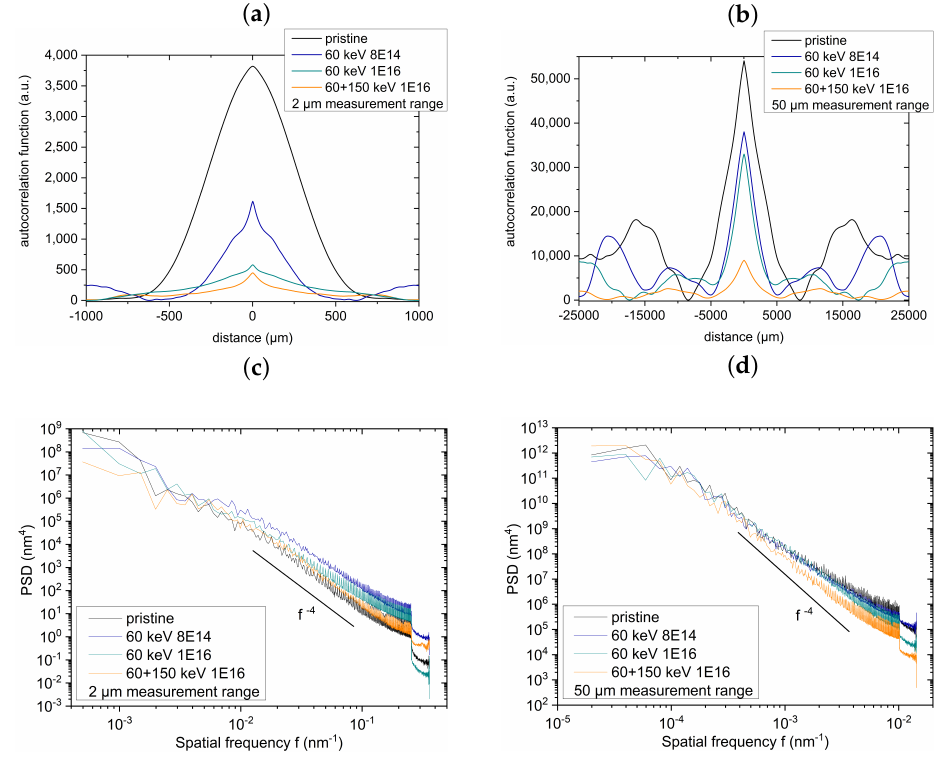
Figure 5. Graphs showing the calculated autocorrelation functions ( a , b ) as well as PSDs ( c , d ) obtained from AFM images of NT arrays bombarded with C depicted in Figure 4. The surface topography was measured in ( a , c ) 2 µ m measurement range and ( b , d ) 50 µ m measurement range. The PSDs obtained from the 2 µ m measurement range are nearly identical with prominent f − 4 behavior, which is in accordance with surface material transport driven by surface